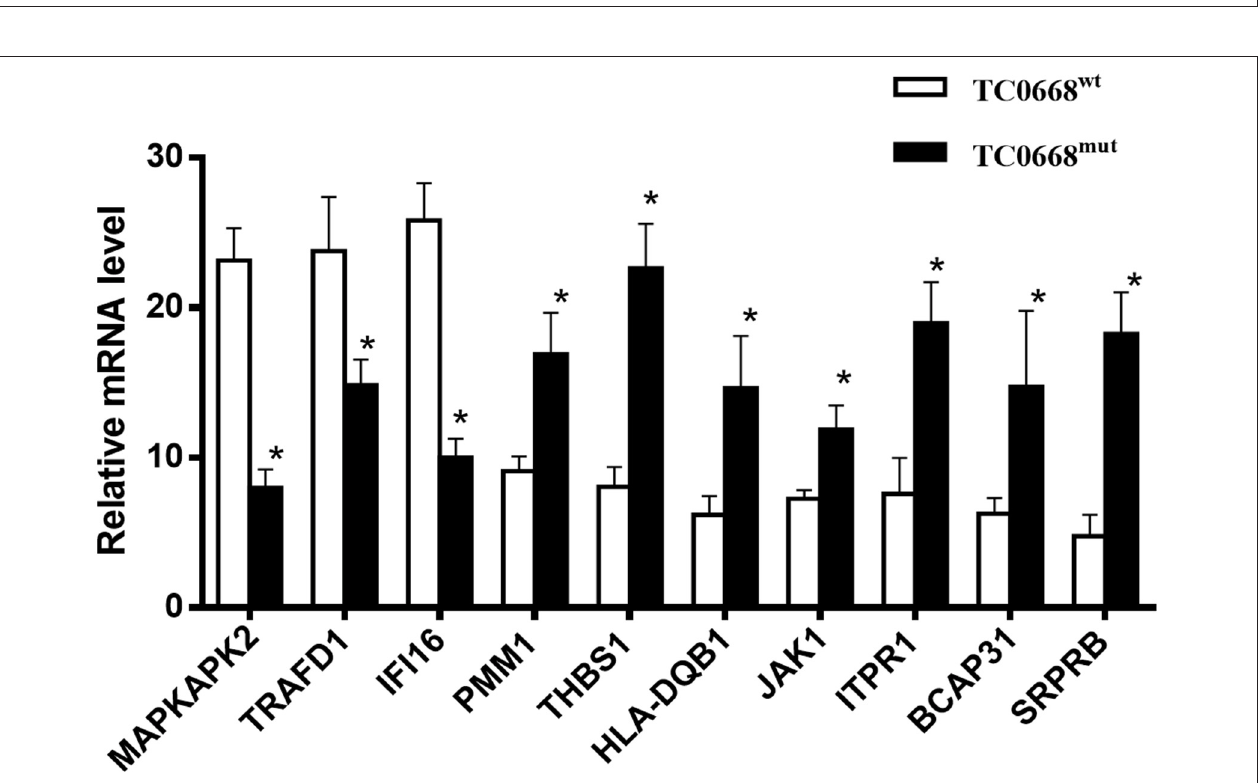
FIGURE 5 | Validation of profiling data with qRT-PCR. mRNA expression levels of seven up-regulated (encoded by SRPRB, JAK1, PMM1, HLA-DQB1, BCAP31, ITPR1, and THBS1) and three down-regulated (encoded by MAPKAPK2, TRAFD1, and IFI16) proteins in C. muridarum TC0668 mut -infected HeLa cells were determined using qRT-PCR at 18h p.i, and compared with those of C. muridarum TC0668 wt -infected group. mRNA levels from three replicates for each group are expressed as mean and the standard errors. *represents that all copy number differences between TC0668 wt and TC0668 mut were statistically significant ( t test, P <